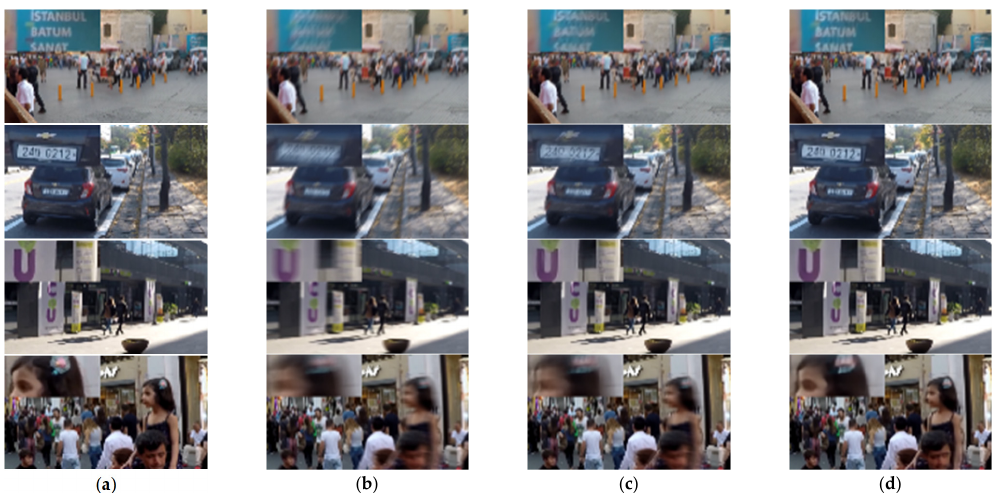
Figure 6. Ablation experiment of multiscale iterative strategy. ( a ) ground truths; ( b ) blurred images; ( c ) deblurring results of single-scale; ( d ) deblurring results of multi-scale.